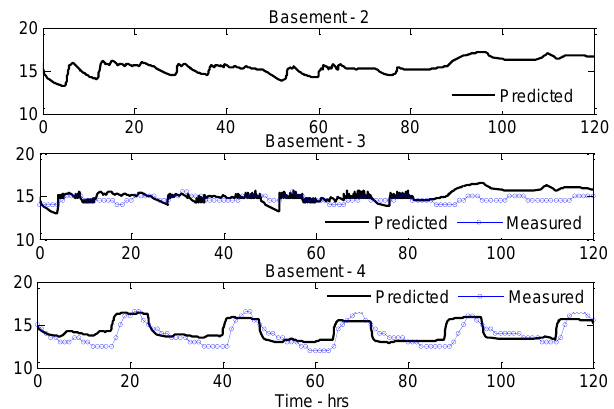
Figure 7: Variation of inside air temperature in the basement-1, basement-2 and basement-3 in the multi-room model [ 0